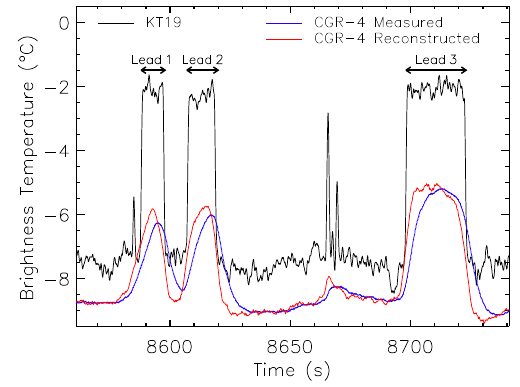
Figure 6. Brightness temperatures of upward terrestrial radiation from KT19 (black) and CGR-4 (blue) on 3 May 2012 above sea ice with leads. The red line shows the reconstructed CGR-4